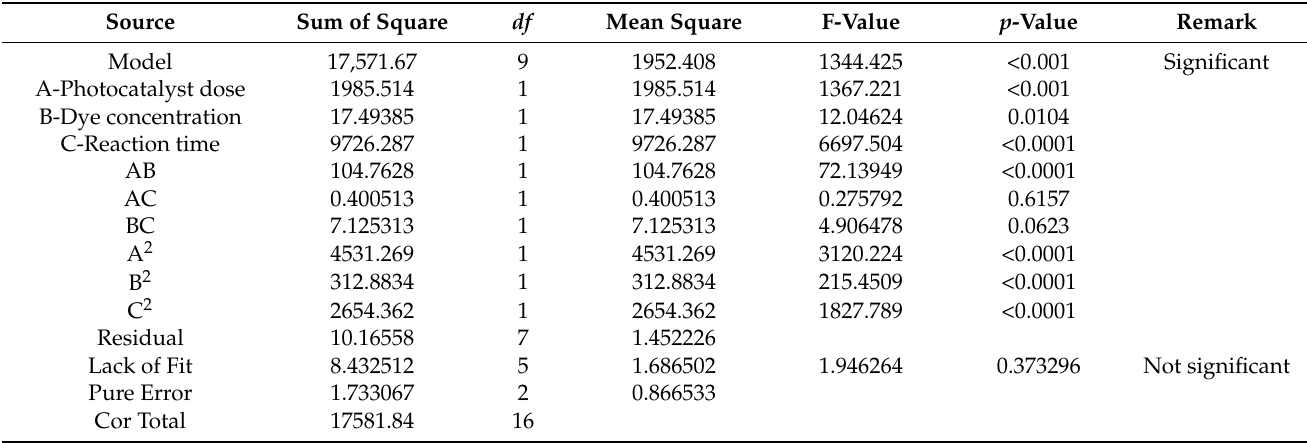
Table 3. ANOVA for the photodegradation of BPB dye.